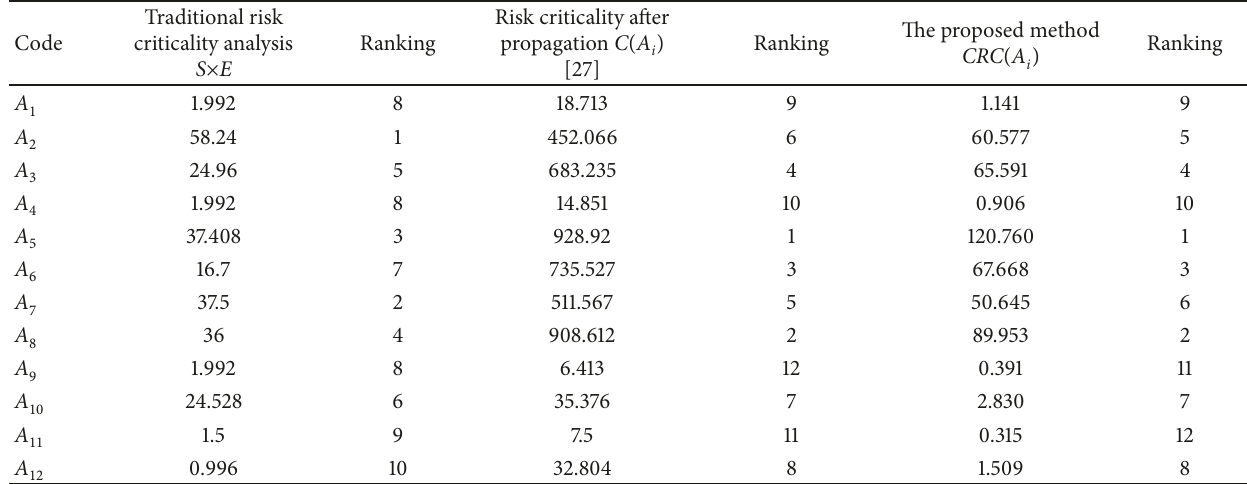
Table 6: Comparison of meta-action risk analysis